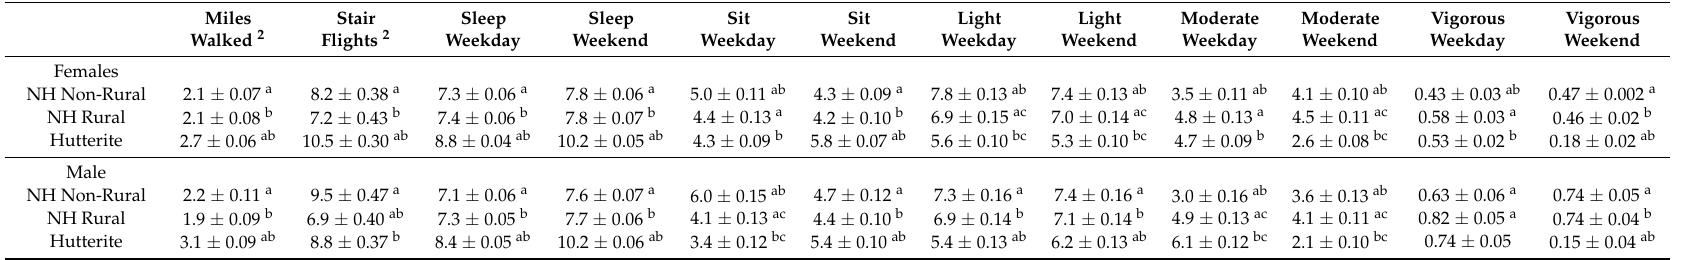
Table 2. Marginal means ( ± SE) and p -values for physical activity (per week and weekend day), stratified by sex. 1,3,4